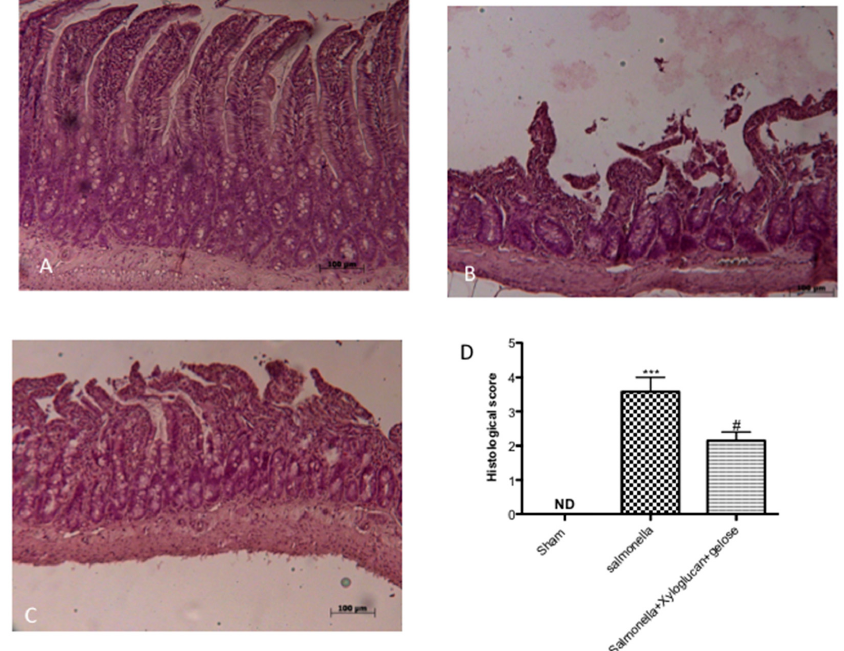
Figure 1. ( A ) The sham group; ( B ) Histological examination of intestine showed transmural necrosis, edema, and leukocyte infiltration in the submucosa of intestine following S. enterica inoculation compared to sham group; ( C ) Xyloglucan + gelose treatments significantly reduced the degree of tissue injury; and ( D ) The histological score. Values are means ± SEM of 10 animals for each group. *** p < 0.001 vs. Sham, # p < 0.05 vs. S. enterica .